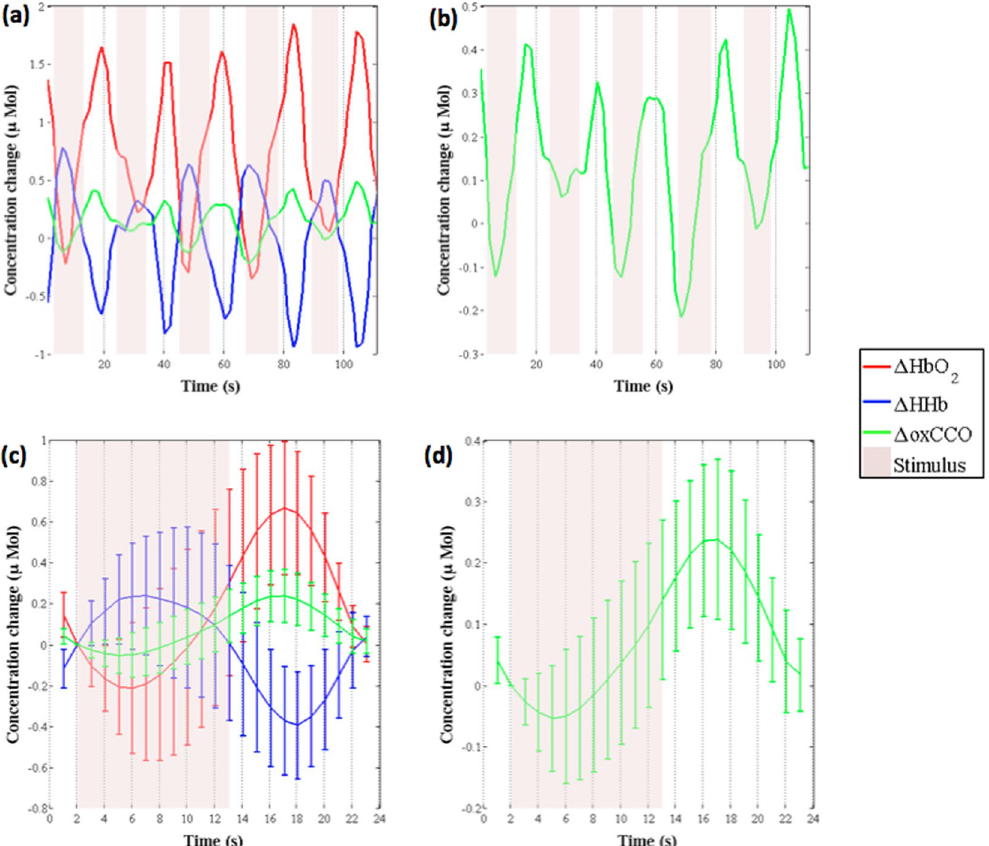
Figure 2. Observed chromophore concentration changes. ( a ) Changes in concentration in HbO 2 , HHb and oxCCO from one participant, across 6 trials, after filtering and applying motion correction. ( b ) Changes in concentration in oxCCO from the same participant, with y-axis re-scaled. ( c ) Grand averaged time course of concentration changes in HbO